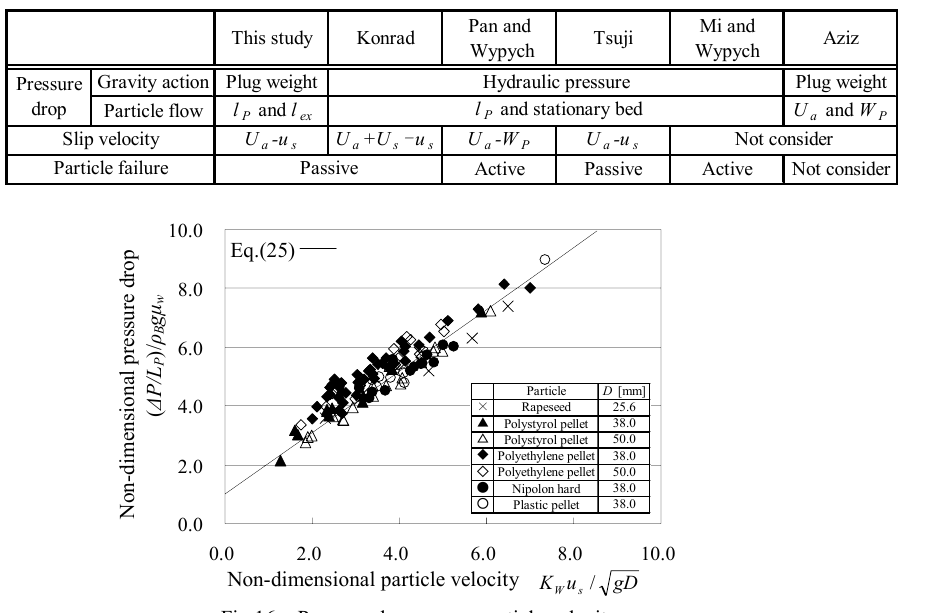
Fig.16 Pressure drop versus particle